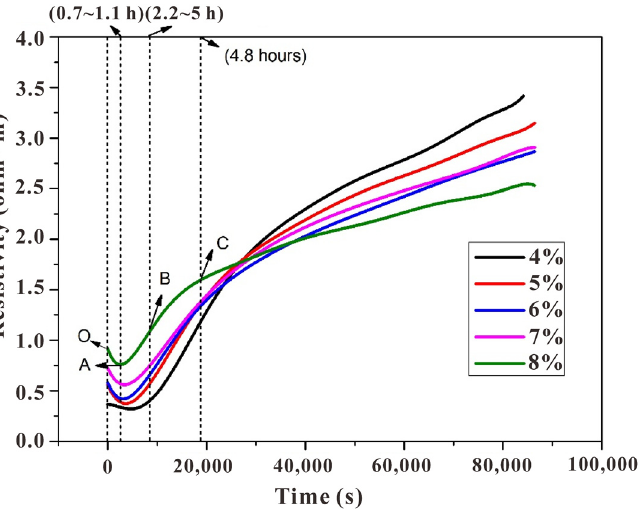
Figure 2. Electrodeless resistivity curves of a slag-based geopolymer with different alkali contents.